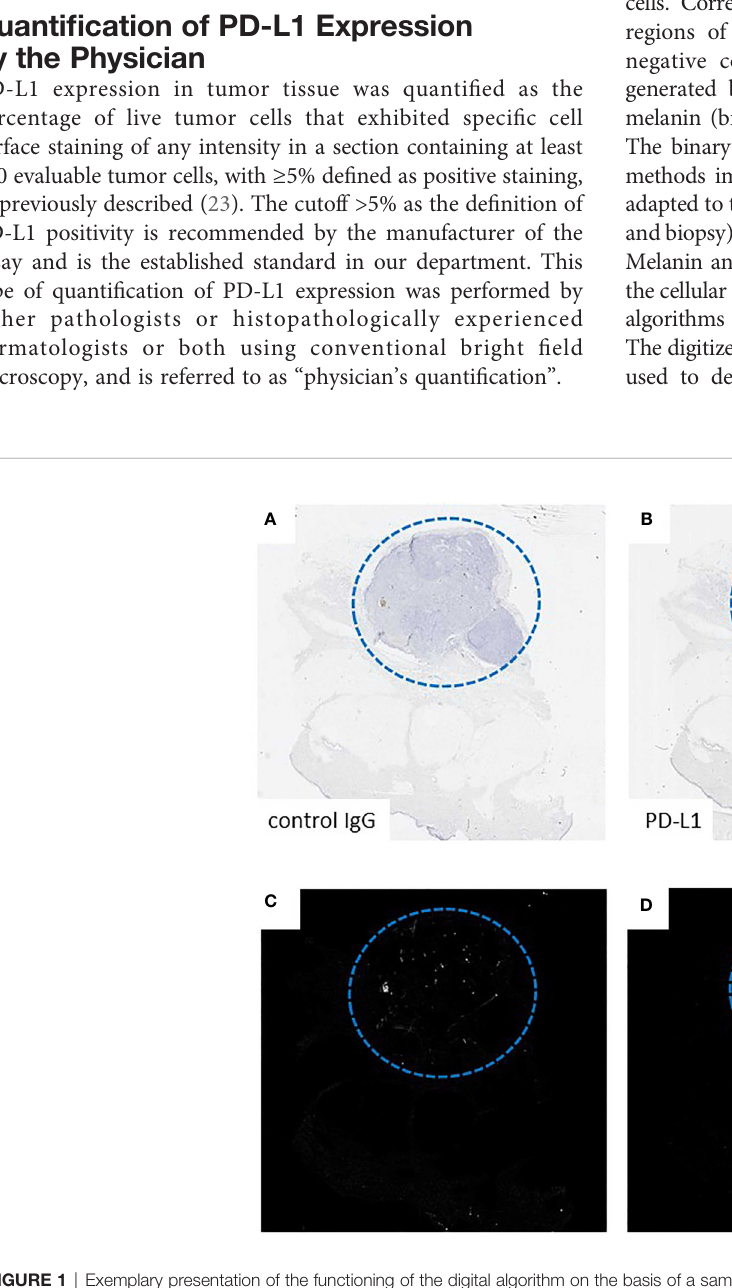
FIGURE 1 | Exemplary presentation of the functioning of the digital algorithm on the basis of a sample from the patient group. Digital quanti fi cation of PD-L1 expression demonstrated on representative tissue slides from a subcutaneous melanoma metastasis. (A, B) Manual selection of the tumor regions of interest on an anti-PD-L1-stained slide and a consecutive negative control IgG-stained slide. (C, D) Binary masks of (A, B)